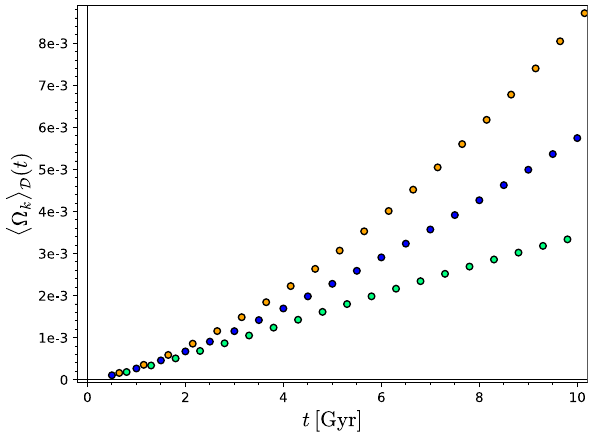
Fig. 9 Average Ω k parameter as a function of time. As on the previous plots, the blue points correspond to K = 0, the orange ones to K = 0 . 1 and light-green points reffer to K = − 0 . 1